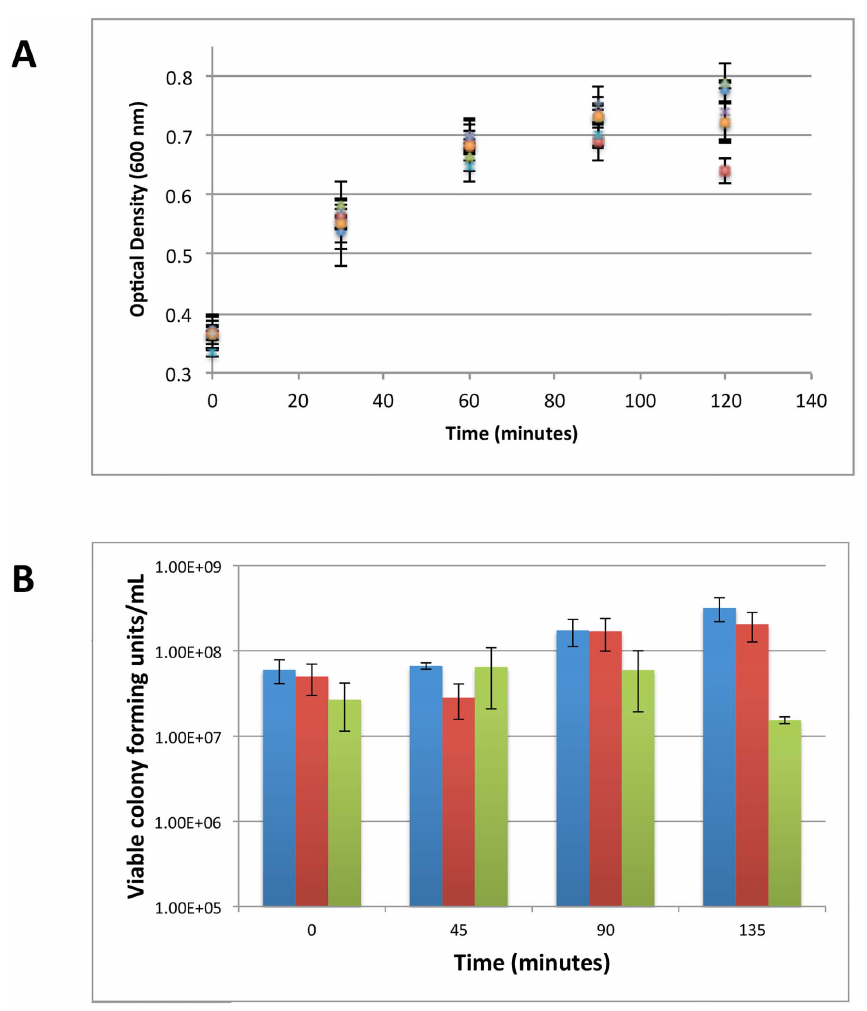
Figure 2. Effect of antibiotic exposure on cells in mid-logarithmic growth. A) Cell viability measured by OD 600 vs time (Key: + : no antibiotic, blue diamond: 1 m g/mL ampicillin, red square: 10 m g/mL ampicillin, green triangle: 2 m g/mL kanamycin, purple cross: 20 m g/mL kanamycin, blue dash: 20 m g/mL fosmidomycin, orange circle: 200 m g/mL fosmidomycin) B) Cell viability measured in viable colony forming units/mL for a representative bactericide (ampicillin) exposure (Key: blue:no antibiotic, red: 1 m g/mL ampicillin, green: 10 m g/mL ampicillin). All values represent the average of at least three independent biological replicates and the error reflects the standard error of the mean.